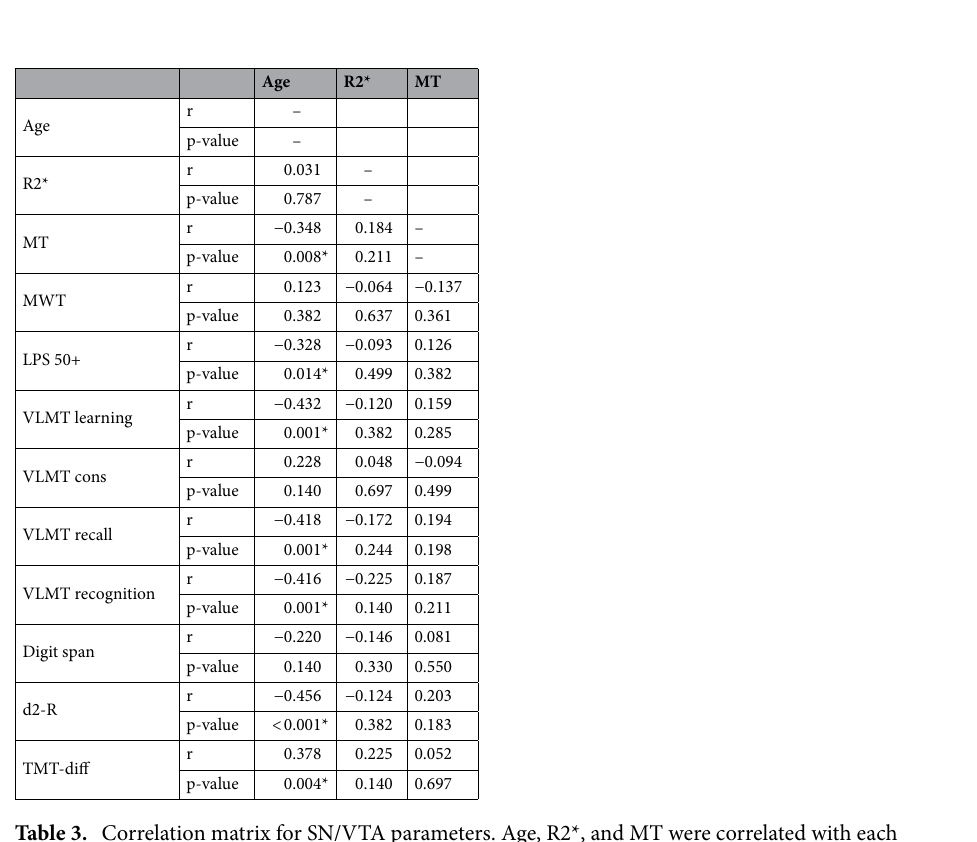
Table 3. Correlation matrix for SN/VTA parameters. Age, R2*, and MT were correlated with each neuropsychological test (Pearson correlation). Benjamini-Hochberg (FDR) p-value adjustment was applied. Significant results are highlighted with an asterisk. Note that there was one missing value for VLMT recognition and that two participants had to be removed from the TMT-diff analysis (> 3 SD, see